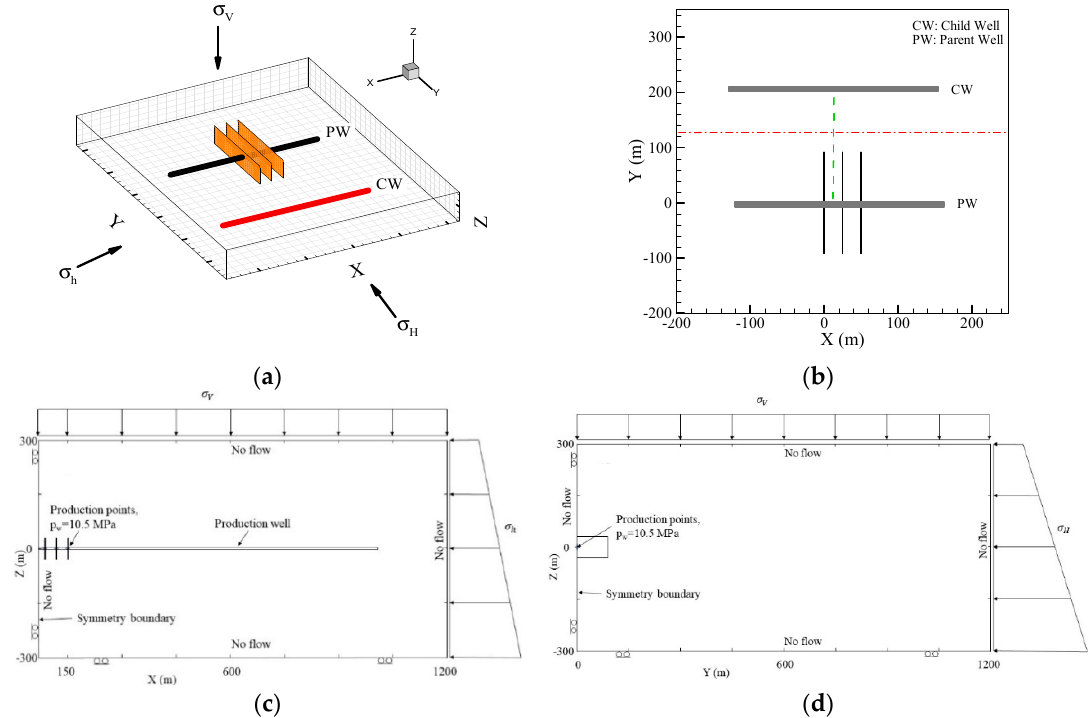
Figure 7. ( a ) A 3D schematic and ( b ) plan-view of reservoir showing “Parent” and “Child” well system (PW: Parent well; CW: Child well). Each production fracture has half-length = 90 (m), height = 60 (m), spacing between horizontal wells = 200 (m) and cluster spacing = 25 (m). For the DD model, the domain boundaries are infinite, whereas for the FEM simulation, the boundary conditions are: ( c ) boundary conditions for one-quarter of the reservoir in the XZ-plane, ( d ) boundary conditions for one-quarter of the reservoir in the